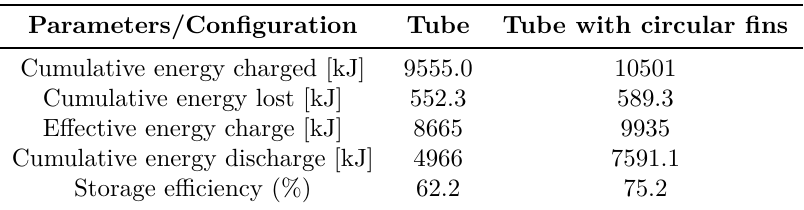
Table 2. Energy charged and discharged and storage